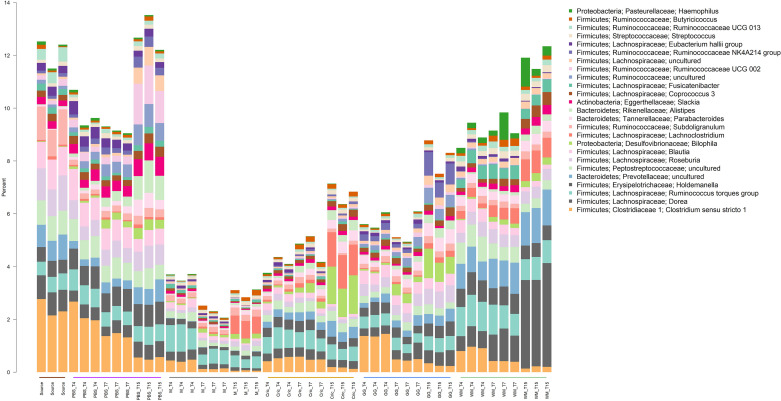
Stacked bar plot of culture community taxonomic composition of taxa at the genus level with mean relative abundances between 0.1 and 1%. Individual culture replicates are shown. “Source” indicates starting inoculum, “PBS” indicates control cultures without added substrates, “M” indicates cultures with digested milk, “Cric” indicates cultures with digested black field cricket, “GG” represent cultures with digested grass grub, and “WM” represents cultures with digested wax moth. “T4”, T7”, and “T15” indicate 4, 7, and 15 h culture times, respectively. Color sidebar along X-axis differentiate different substrates.